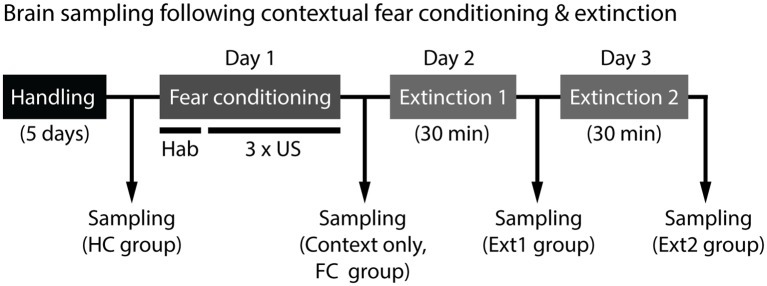
Experimental scheme for brain sampling to analyze c-Fos expression. Brains were collected from mice 45 min after each condition except for home cage (HC) group, where mice were taken directly from their HCs. Contextual fear conditioning consisted of 5-min of habituation (hab) and three unconditioned stimulus (US) exposures (foot shock, 0.6 mA, 2 s) in the conditioning context. Fear extinction was performed 24 h later for 2 days. Mice were placed in the same conditioning context without shocks for 30 min on two consecutive days.